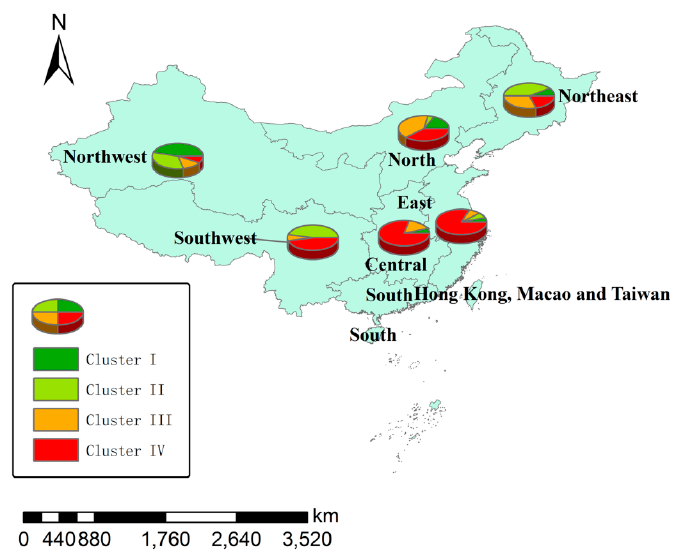
Figure 4. The composition of clusters in different regions of China.